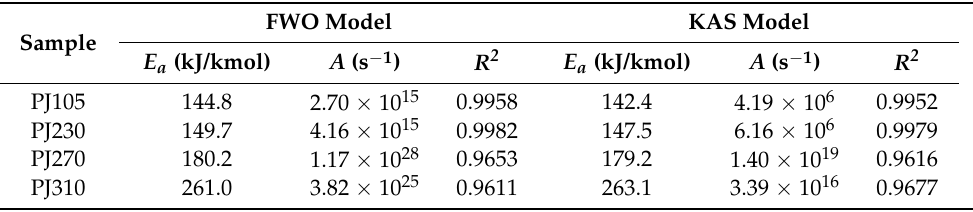
Table 5. Kinetic parameters obtained from FWO and KAS methods for samples.